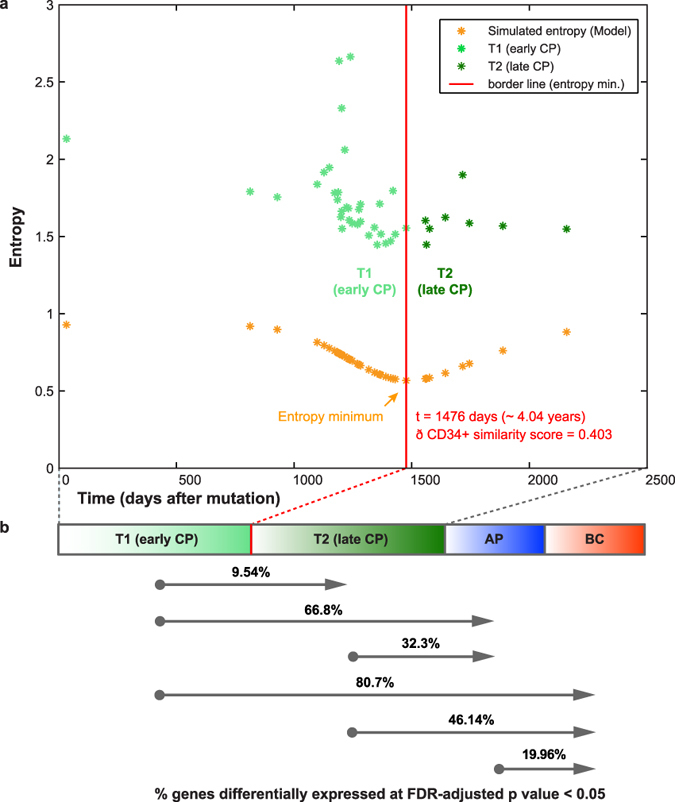
Entropy-based separation of early vs. late chronic phase (CP) patients.
(a) Integrating CD34+ similarity score with entropy of patient gene expression and simulated entropy resolves differences in patient disease evolutionary time. 42 CP patients (asterisks) plotted by observed entropy from clinical gene expression data aligned by model-derived simulated entropy converted to disease time span (days). Time span covers ~6 years in accordance with the model. The red borderline separates “early” (T1) from “late” (T2) CP patients (light and dark green asterisks, respectively) at the simulated entropy minimum singularity at t = 1476 days (~4.04 years), and CD34+ similarity score = 0.403. b. T1 and T2 CP patient groups are significantly different in terms of gene expression (T1 vs. T2, FDR-adjusted p < 0.05). Progression towards advanced stage is highlighted by increasing differential gene expression compared to AP and BC, where the fraction of differentially expressed genes of T1-CP vs. AP (66.8%) > T2-CP vs. AP (32.3%), and T1-CP vs. BC (80.7%) > T2-CP vs. BC (46.14%).